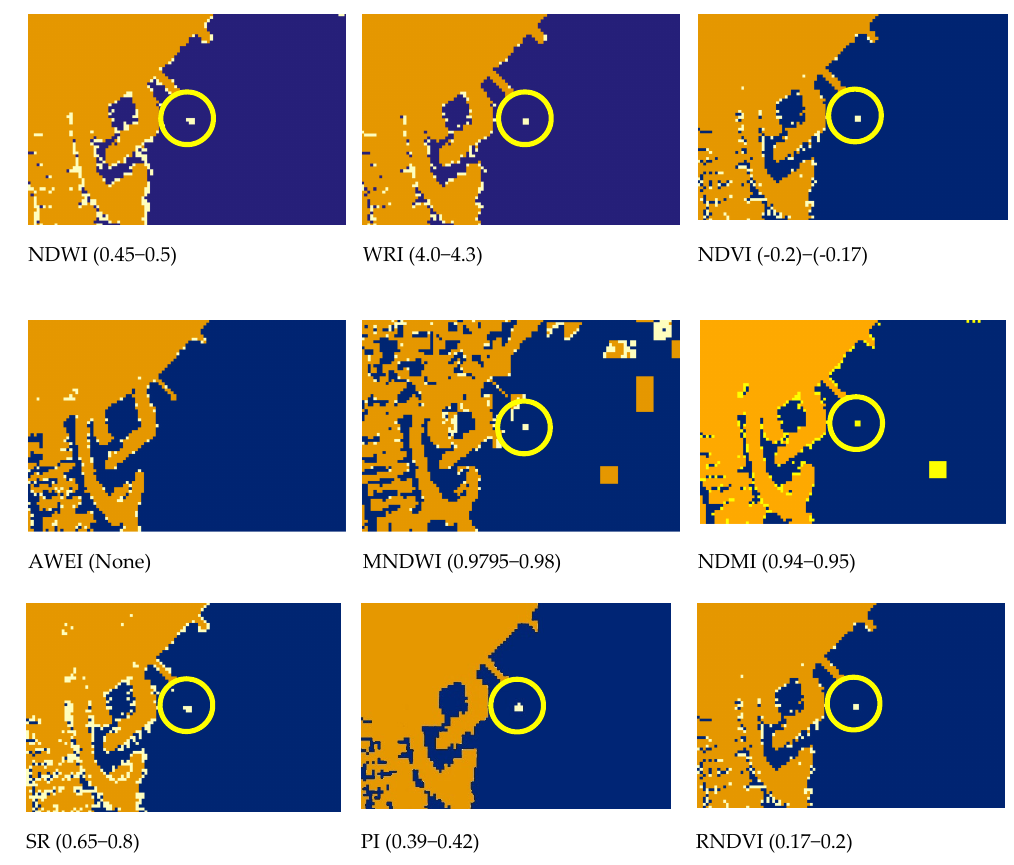
Figure 9. Sentinel-2 Satellite image (15 December 2018) processed with the indices described in the text with the corresponding values for which the plastic was detected. Land is represented in orange, water is represented in blue and plastic is represented in yellow. The yellow square within the yellow circle is the plastic litter target during the satellite overpass which corresponds to the Plastic Index Values (PIV), which is in the parentheses for each index.